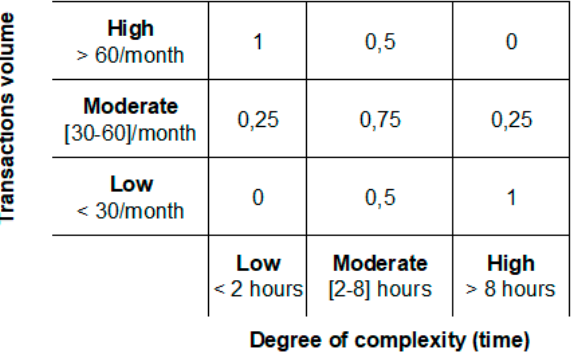
Figure 6. Adopted scale for priority index calculation.